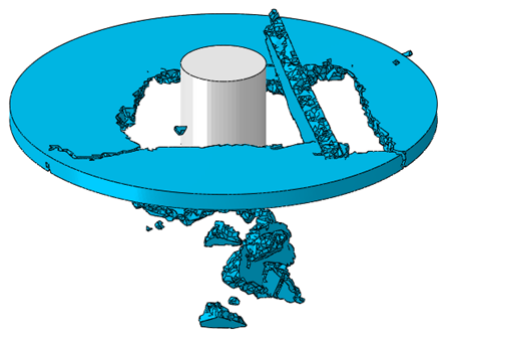
Fig. 12 Comparison of simulation results of glass with immediate failure model to experimental data for drop weight impact.